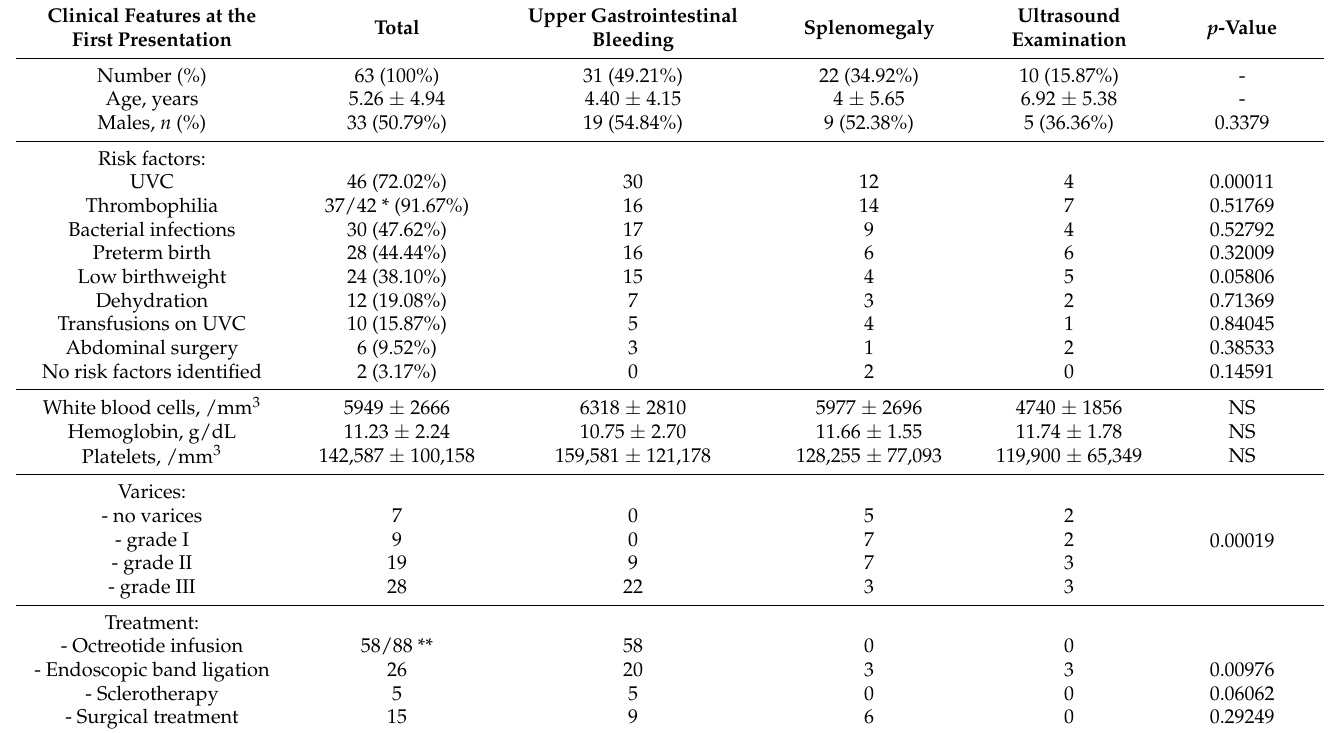
Table 1. Comparison between children with EHPVT depending on the clinical